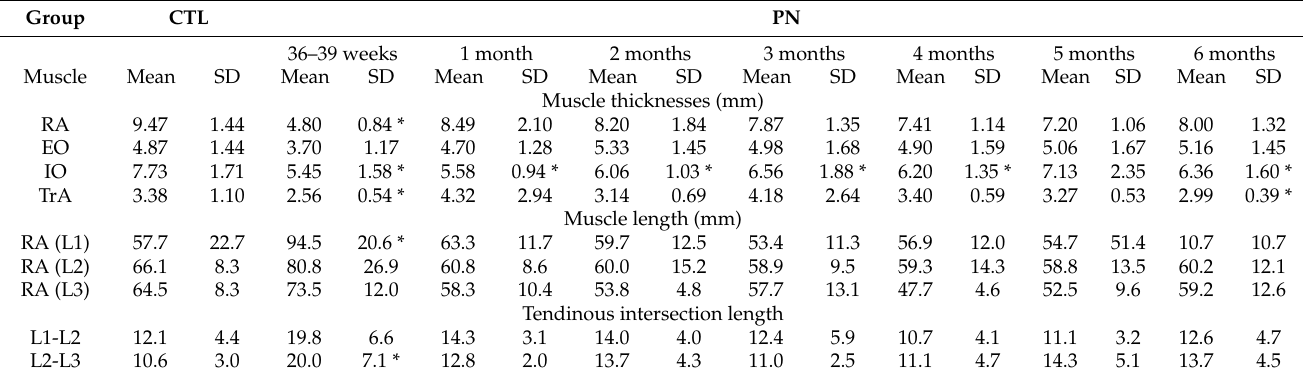
Table 2. Comparison of abdominal muscle thickness and length between perinatal and control groups.